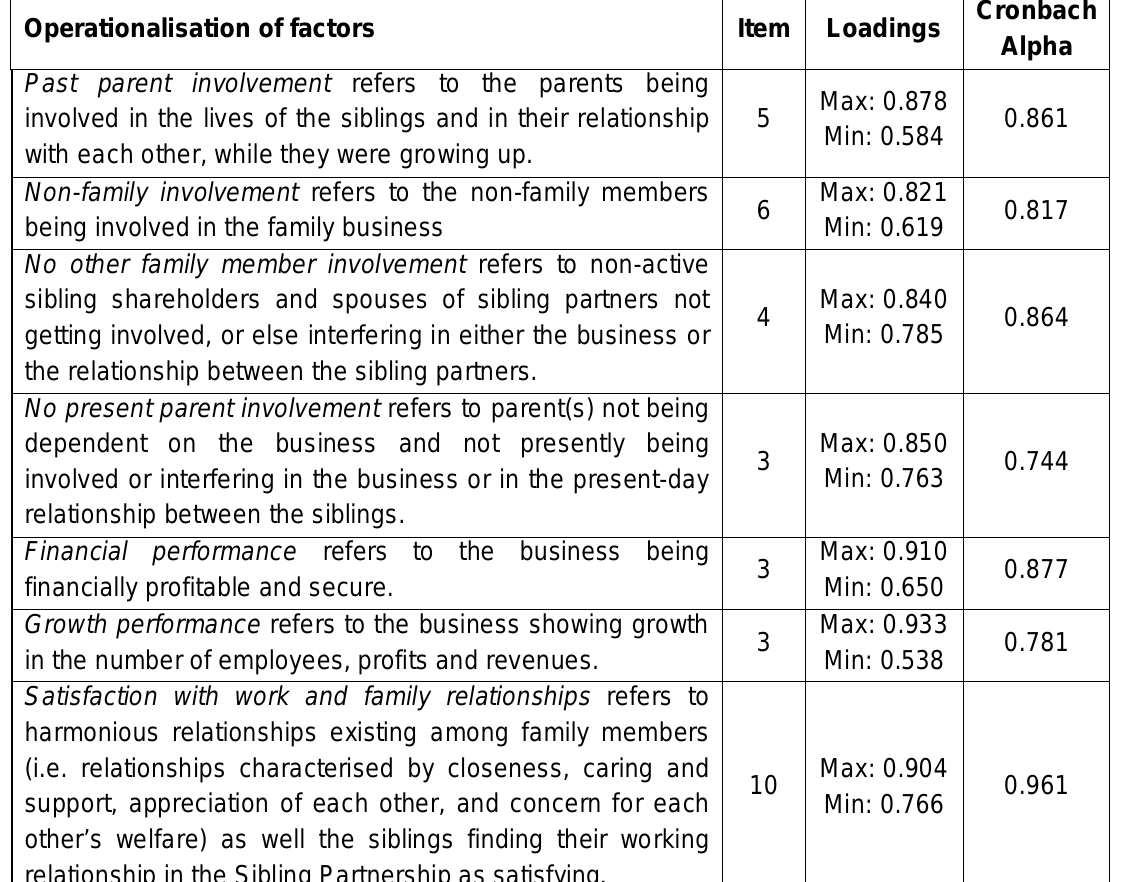
Table 1 Measurement instrument analyses* Operationalisation of factors Item Loadings